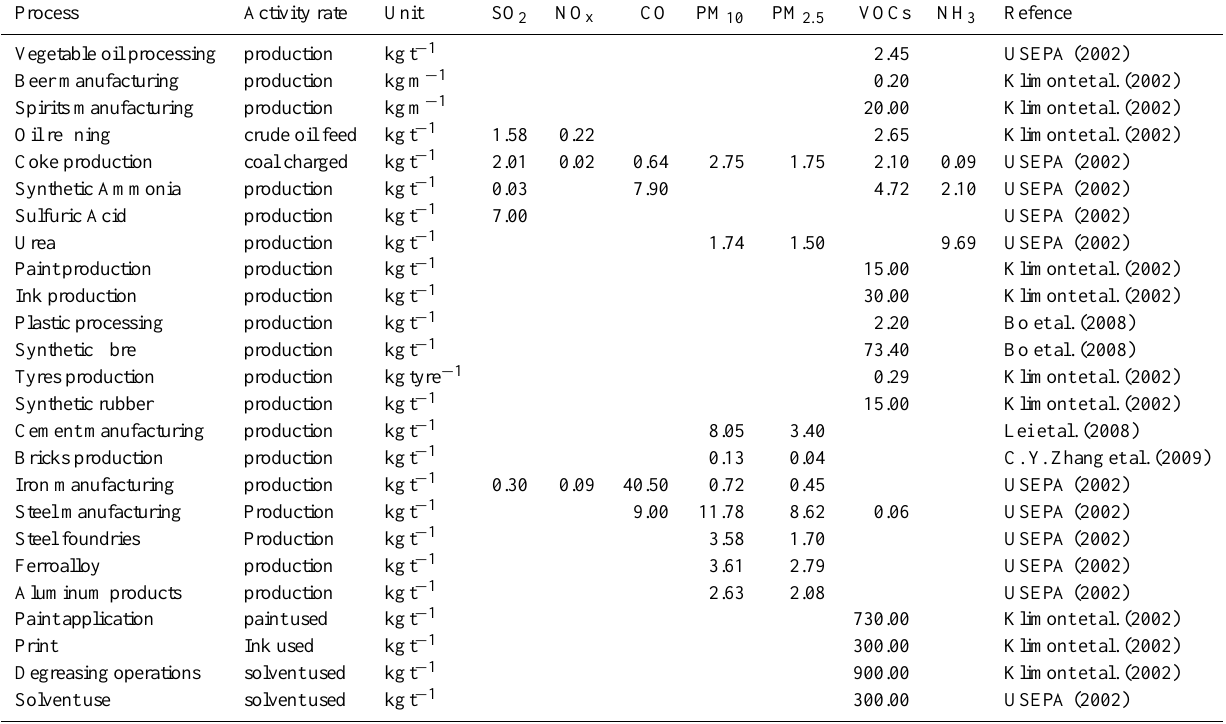
Table 3. Emission factors of industrial process